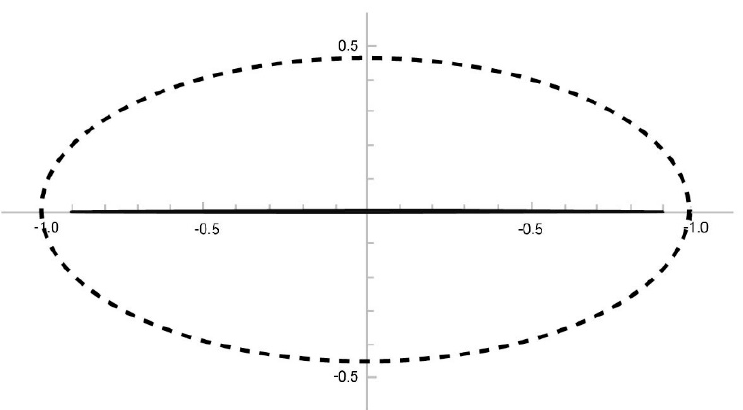
ca )( TH c 23 TH a and )( versus temperature of the La 1.85 Sr 0.15 CuO 4 -a superconduc- c 2 a )( TH a ( T ) ( T ) versus temperature of the La c 3 and H a c 2 H a c 2 ( T ) TH a versus temperature of the La 1.85 Sr 0.15 CuO 4 -a superconduc- c 2